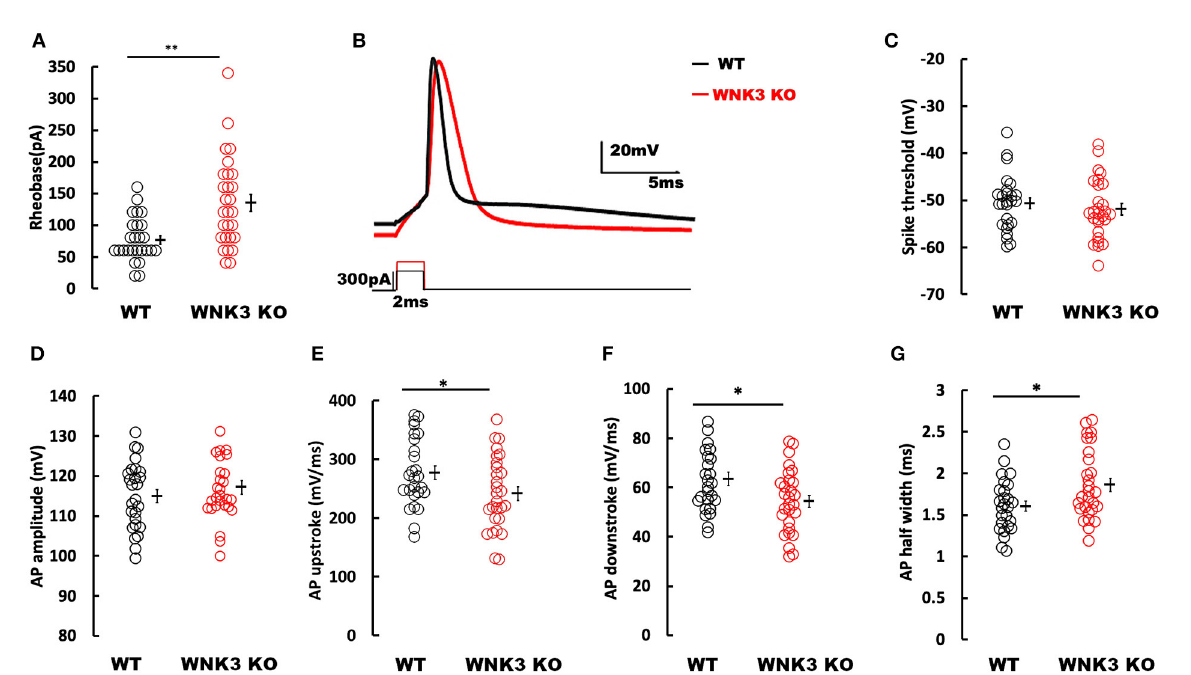
FIGURE6 Loss of WNK3 reduces intrinsic excitability and increases single action potential (AP) duration of layer V pyramidal neurons in the mPFC. (A) Quantitative analysis of rheobase currents. Rheobase currents from layer V pyramidal neurons are significantly increased in the WNK3 KO group when compared to the WT group (black, WT = 76.92 ± 6.8pA, n = 26; red, WNK3 KO = 135 ± 13.4pA, n = 28; Mann–Whitney U test , ** P < 0.01). (B) Representative single AP waveforms elicited by a short pulse (2 vms) protocol (black, WT; red, WNK3 KO). Note that both the rise slope and decay slope are slower in WNK3 KO, leading to an increase in AP half-width. Scale bar as shown in inset (20mV, 5ms). (C) Quantitative analysis of AP threshold voltages shows no significant differences within groups (WT = − 50.61 ± 1.14mV; WNK3 KO = − 51.93 ± 1.18mV; t- test , ns ). (D) AP amplitudes are not significantly different between groups (WT = 114.98 ± 1.64mV; WNK3 KO = 117.16 ± 1.66mV; t- test , ns ). (E) AP upstrokes are significantly slower in WNK3 KO neurons (WT = 276.85 ± 11.53 mV/ms; WNK3 KO = 241.52 ± 11.78 mV/ms; t- test , * P < 0.05). (F) AP downstrokes are significantly slower in WNK3 KO neurons (WT = 63.42 ± 2.78 mV/ms; WNK3 KO = 54.49 ± 2.42 mV/s; t- test , * P < 0.05). (G) AP half-maximal widths are significantly prolonged in the WNK3 KO group (WT = 1.61 ± 0.06ms; WNK3 KO = 1.86 ± 0.08ms; t- test , * P < 0.05). Individual data points are plotted as WT (black open circles) and WNK3 KO (red open circles). Mean values are indicated with solid bars next to the data points. Error bars represent